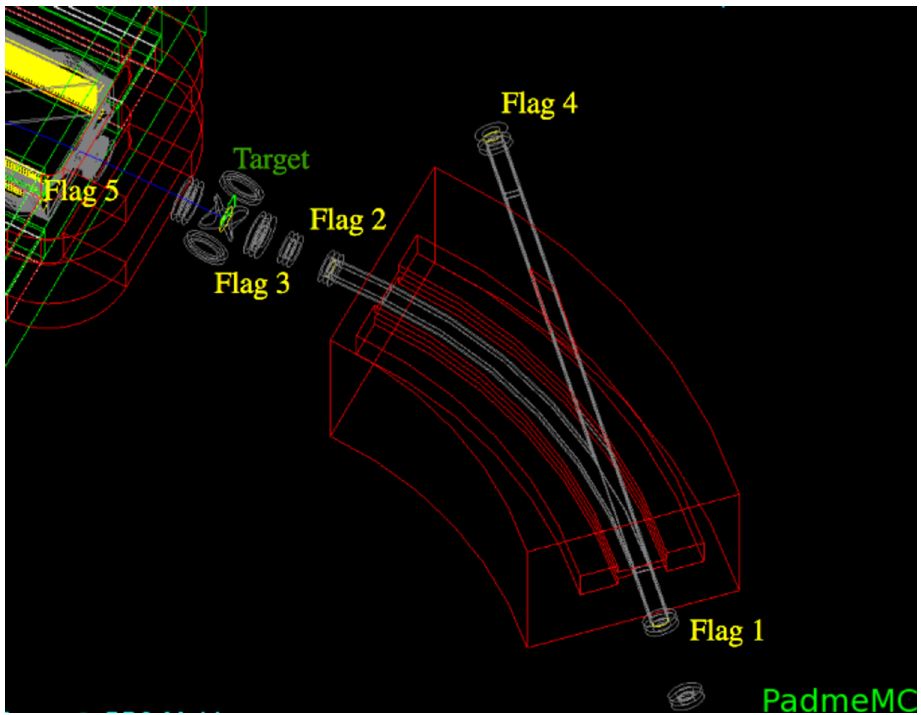
Figure 1 . Detailed view of the PADME target region: in green Target with its support, in yellow the beam “Flags”, and in red the BTF DHSTB002 dipole magnet. On the top left side part of the PADME dipole